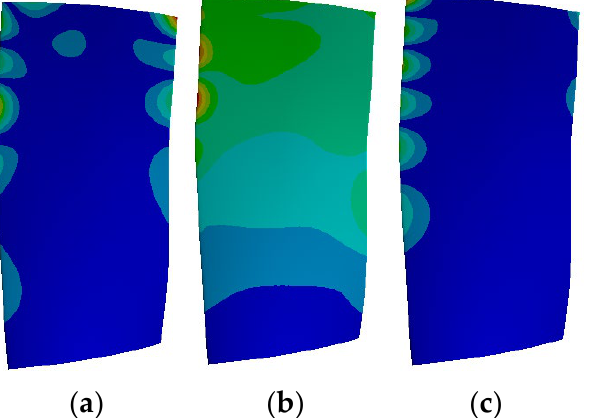
Figure 22. 54 EO component of static pressure at 80% blade span of R1 rotor blade. ( a ) Amplitude ( b ) Phase angle.